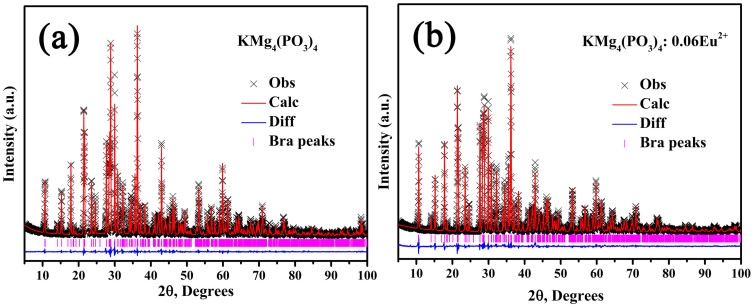
Powder XRD pattern (×) of (a) KMg4(PO4)3 host and (b) KMg4(PO4)3:0.06Eu2+ samples with their corresponding Rietveld refinement (solid line) and residuals (bottom).